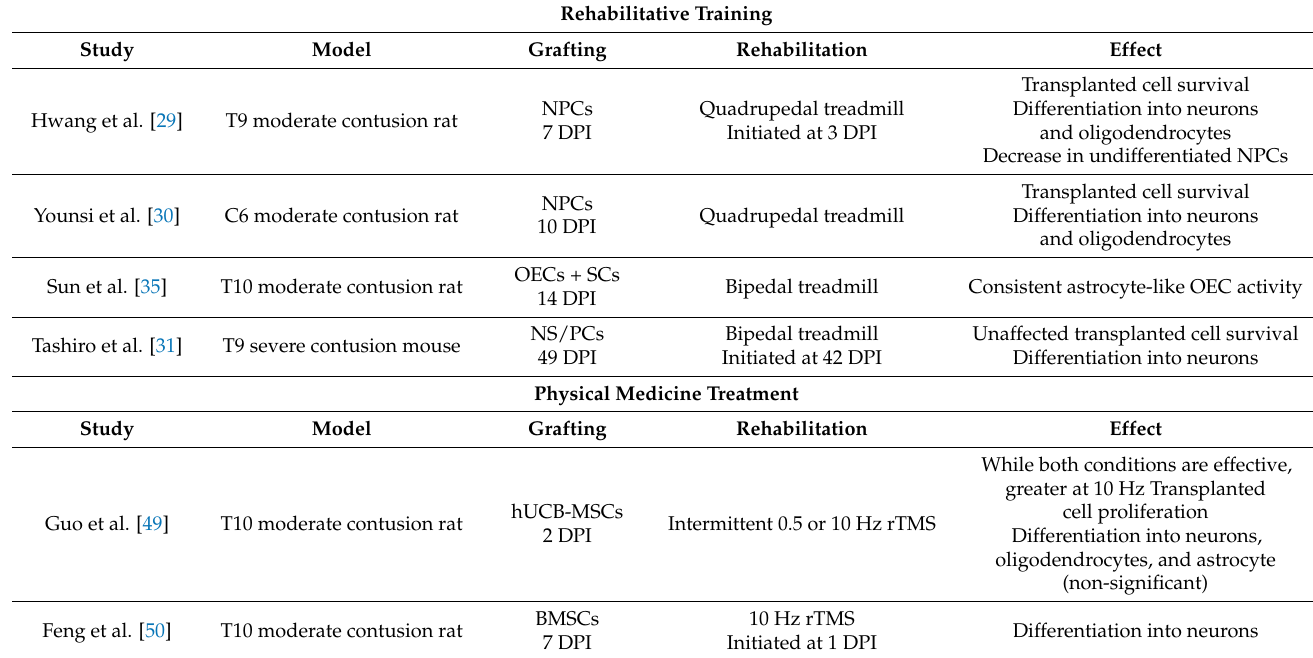
Table 1. Direct effects of transplanted